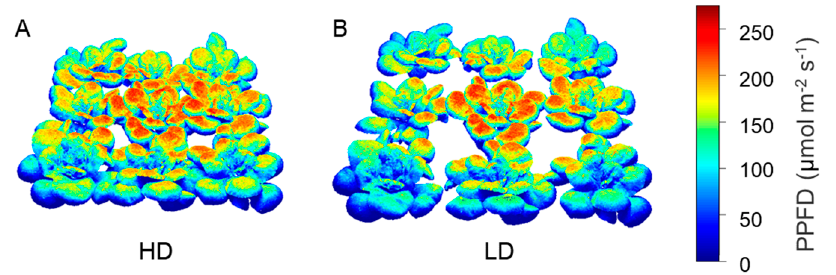
Figure 6. Simulation results of light distribution on the lettuce canopy for HD ( A ) and LD ( B ). HD and LD indicate high planting density (25 plant m − 2 ) and low planting density (16 plant m − 2 ), respectively.